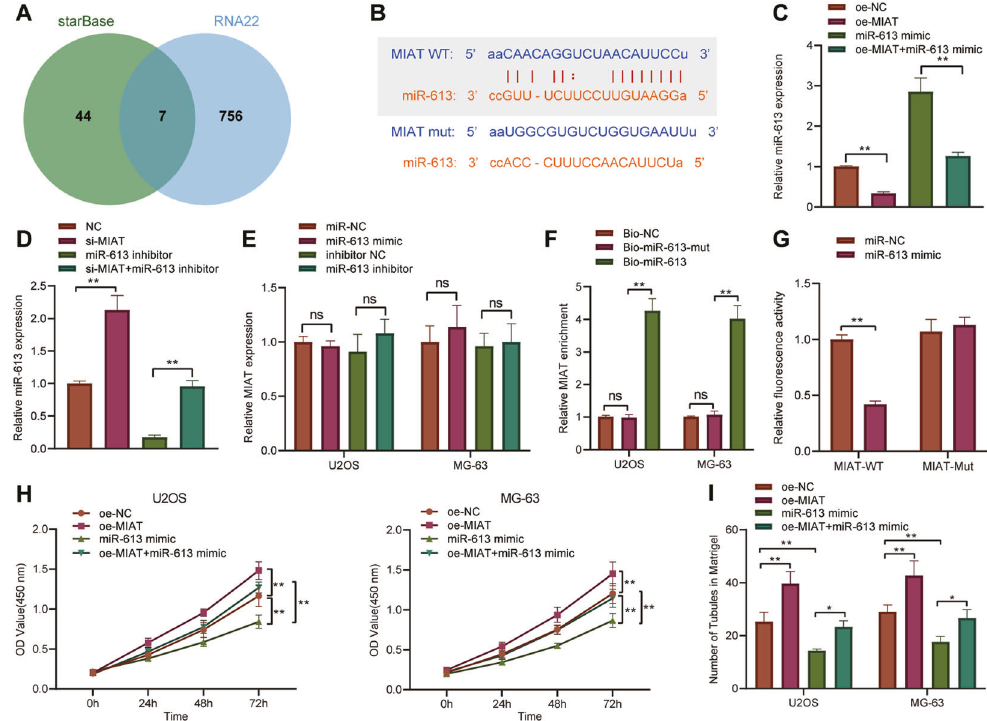
Fig. 4 MIAT competitively binds to miR-613, accelerating the proliferation and angiogenesis of osteosarcoma cells. A Venn diagram analysis of downstream miRNAs of MIAT predicted by the starBase and RNA22 databases. B The predicted binding sites between MIAT and miR-613 by the starBase database. C miR-613 expression determined by RT-qPCR in U2OS and MG63 cells transfected with oe-MIAT, miR-613 mimic, or both. D miR-613 expression determined by RT-qPCR in U2OS and MG63 cells transfected with si-MIAT, miR-613 inhibitor, or both. E MIAT expression determined by RT-qPCR in U2OS and MG63 cells transfected with si-MIAT, miR-613 inhibitor, or both. F Enrichment of MIAT in U2OS and MG63 cells transfected with Bio-miR-613 or Bio-miR-613-MUT assessed by RNA pull-down assay. G Binding of miR-613 to MIAT con fi rmed by dual-luciferase reporter assay. H Proliferation of U2OS and MG63 cells transfected with oe-MIAT, miR-613 mimic, or both measured by CCK-8 assay. I Angiogenesis of U2OS and MG63 cells transfected with oe-MIAT, miR-613 mimic, or both measured by microtubule formation in vitro. * p < 0.05, ** p < 0.01. All experiments were conducted three times independently.